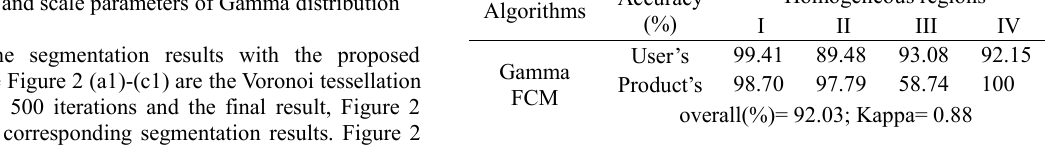
Table 1. Shape and scale parameters of Gamma distribution